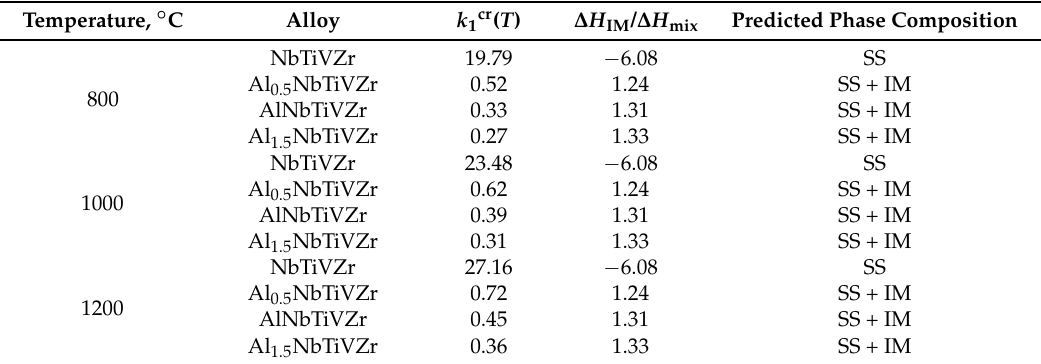
Table 4. Calculated k 1cr ( T ) and ∆ H IM / ∆ H mix parameters and predicted phases for the Al x NbTiVZr ( x = 0; 0.5; 1; 1.5) alloys at 800 ◦ C, 1000 ◦ C and 1200 ◦